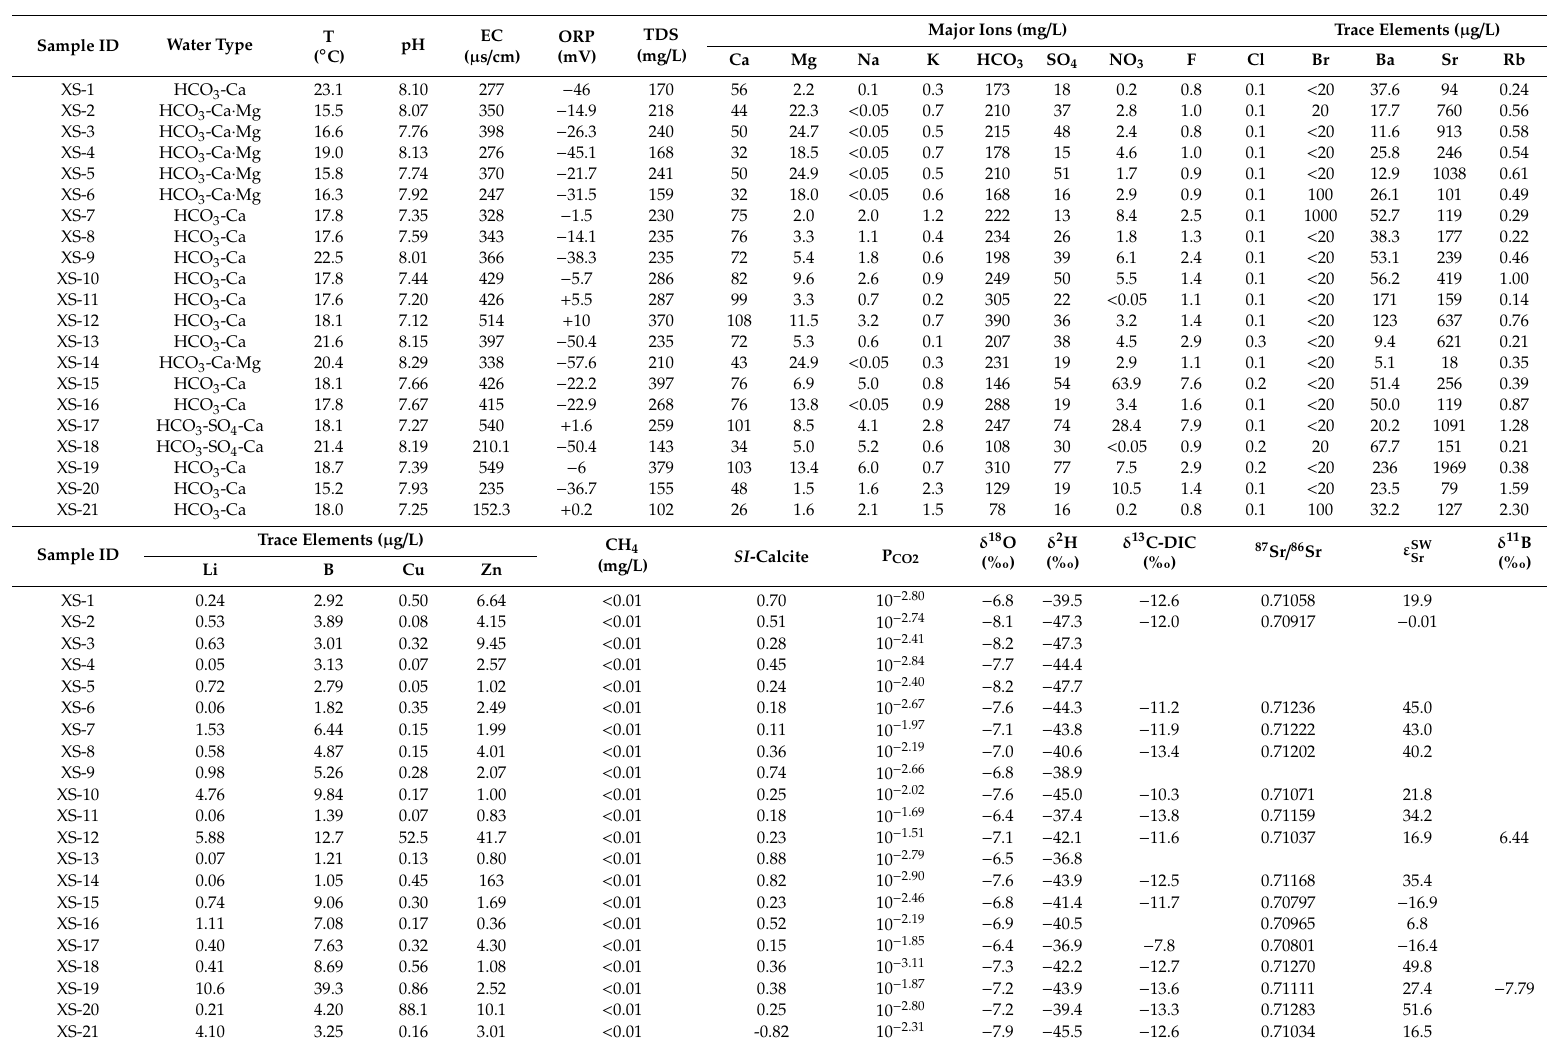
Table 1. Chemical and isotopic composition of shallow groundwater samples of the study